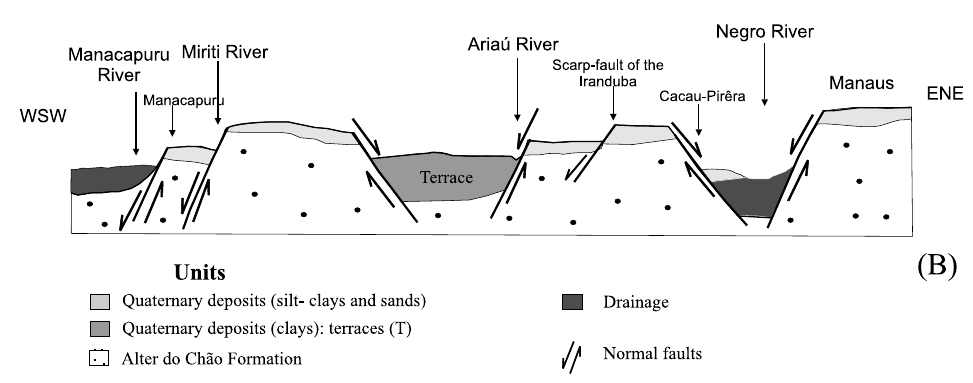
Fig. 9 – (A) 3-D model (vertical exaggeration of 80 times) with the main morphotectonich compartments of the region to the southwest of Manaus. (B) geological section (without scale) between compartments I and II.